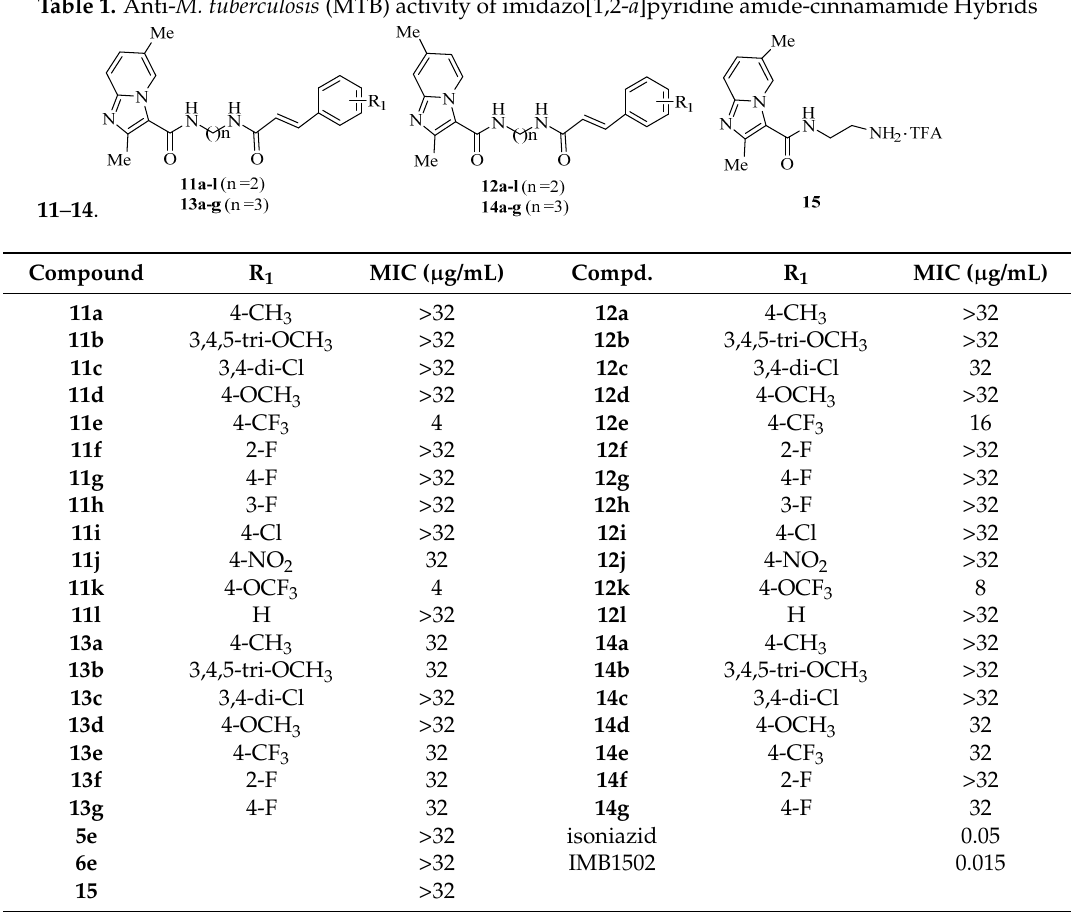
Table 1. Anti- M. tuberculosis (MTB) activity of imidazo[1,2- a ]pyridine amide-cinnamamide Hybrids 11 – 14